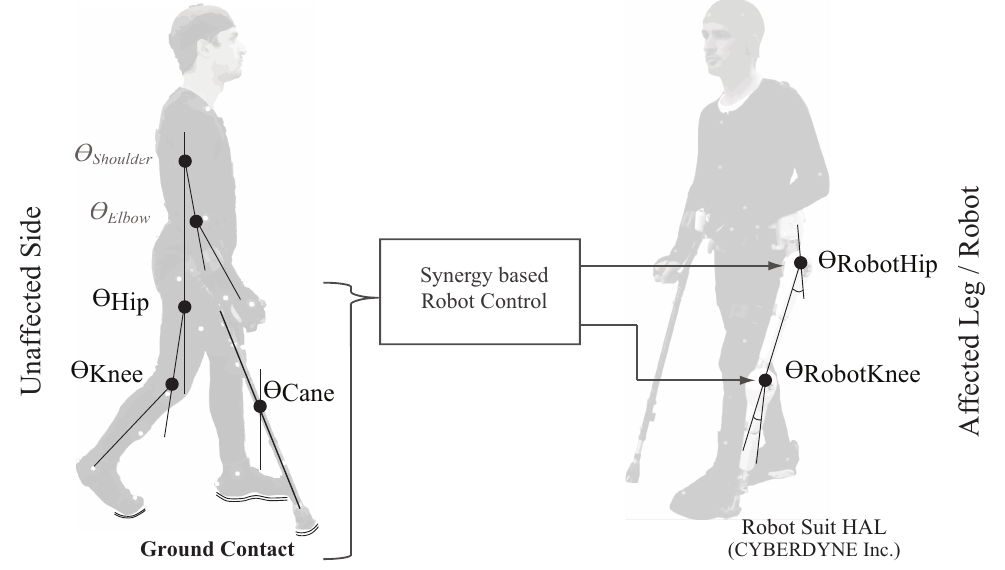
Figure 1. Illustration of the measured joint angles in the proposed system, and the concept of synergy based